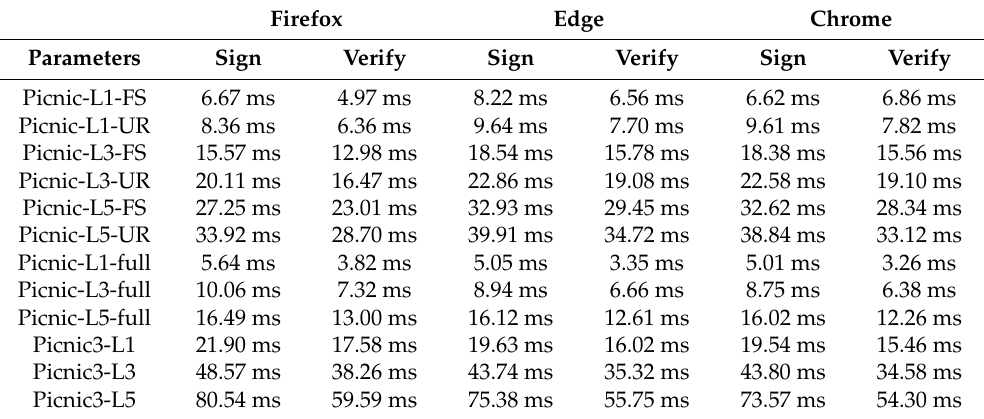
Table 6. Performance of picnic (Web Assembly implementation)